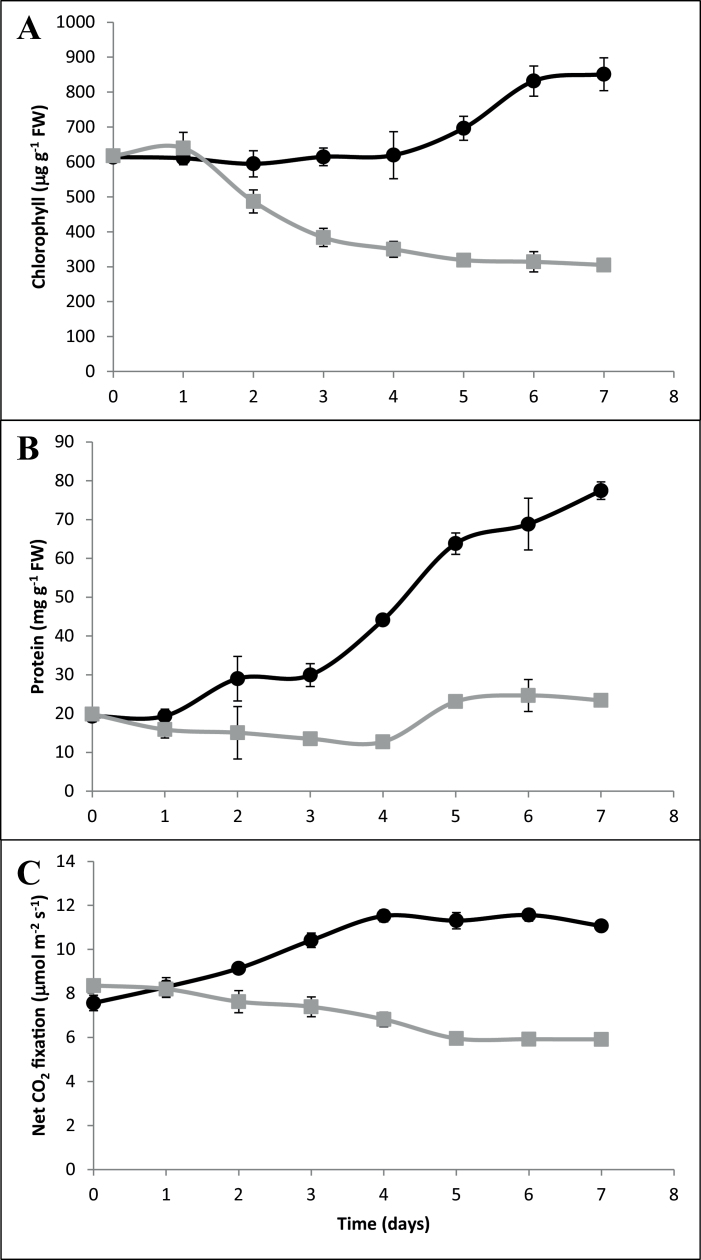
Impact of N availability on leaf chlorophyll, protein and gas exchange in barley. Plants were grown under N repletion or N deficiency as described in the text. Total leaf chlorophyll content (A), protein (B) and net CO2 fixation (C) were estimated as described. Points represent mean values and bars standard error (n=5). Data from plants grown under N-replete conditions are indicated by black circles and from those grown under N deficiency, grey squares.